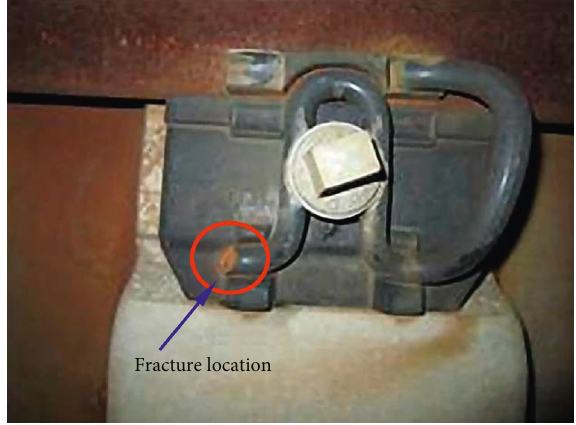
Figure 2: ω -type fastening clip